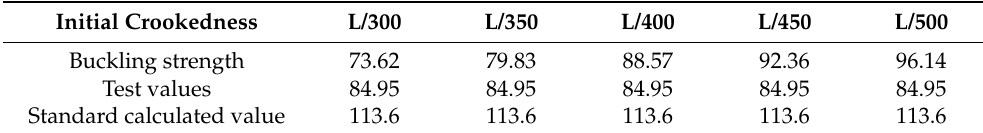
Table 2. Ultimate stability bearing capacity of brace under different initial bending